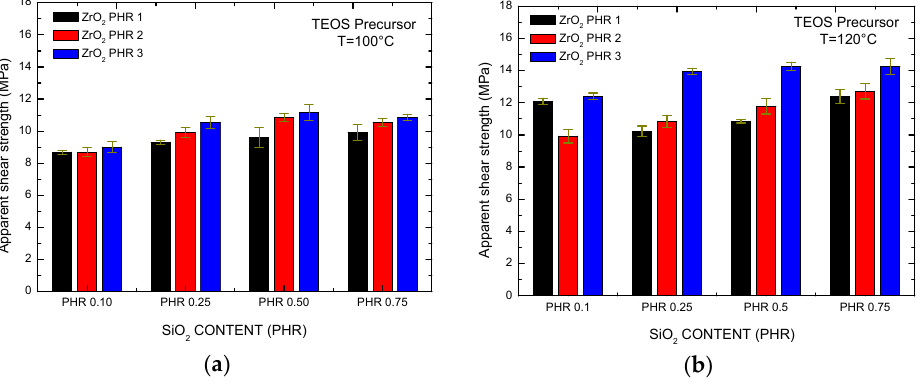
Figure 13. Apparent shear strength of epoxy-SiO 2 -ZrO 2 adhesives using TEOS as a precursor at different temperatures: ( a ) T = 100 °C; ( b ) T = 120 °C.